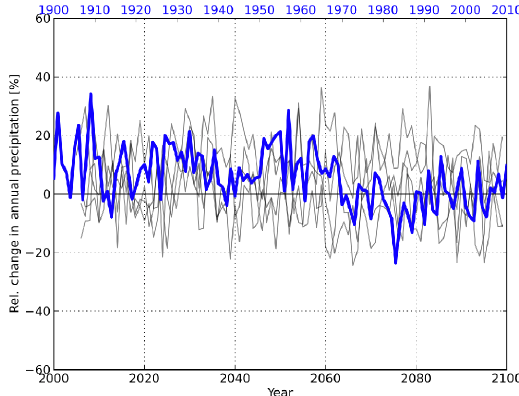
Figure 7. Projections of rel. changes in annual precipitation for West Africa, from 5 GCMs, randomly picked from ISI-MIP bias corrected data (grey). The blue line shows the observed variability in precipitation for the last 100 years (upper x axis) from UDEL data (Willmott et al.,